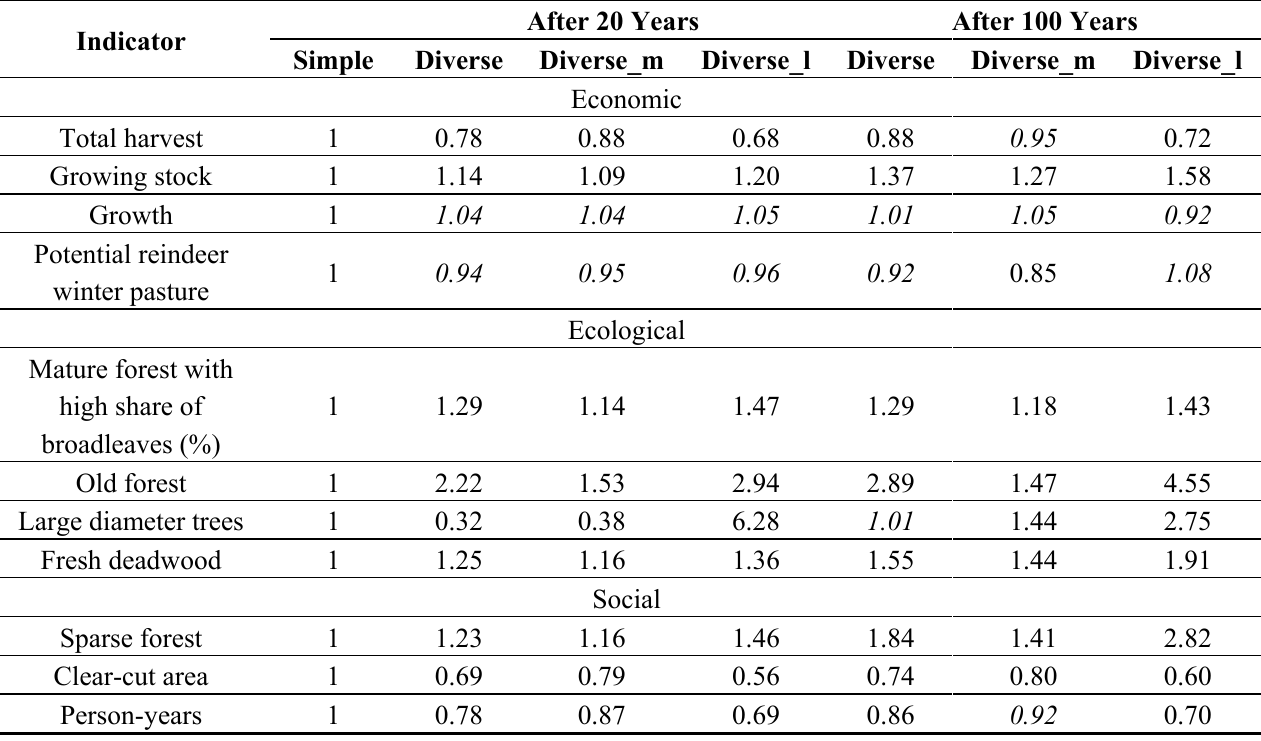
Table 11. Ratio between the Diverse (Diverse_m, Diverse_l) and the Simple scenario (with Simple as reference; Simple = 1) after 20 and 100 years of simulation for Vilhelmina (Simple = 1). For Total harvest, Growth and Clear-cut area, the ratio between the averages for the first and the last 20 years of simulation was used (Average 0–20 years [Diverse]/Average 0–20 years[Simple] for the first 20 years, and Average 80–100 years [Diverse]/Average 80–100 years[Simple] for the last 20